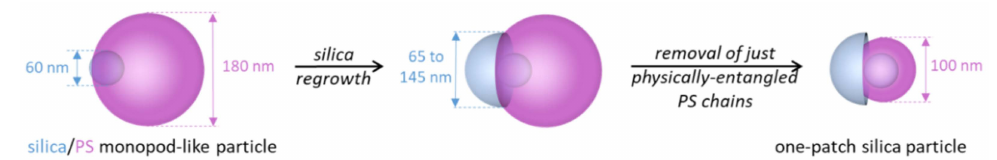
Figure 1. Two-step synthesis pathway to obtain silica particles with one PS patch of a tunable relative size from silica/PS monopod-like